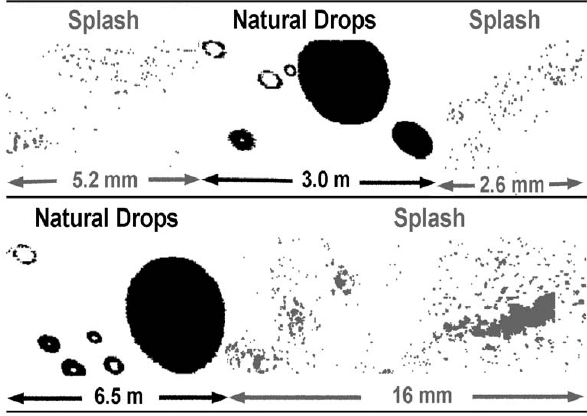
Figure B.4 . Example of 2D-S images in raindrops with particles in grey identified as artifacts using the algorithms described in this Appendix (from Baker et al. 2009)